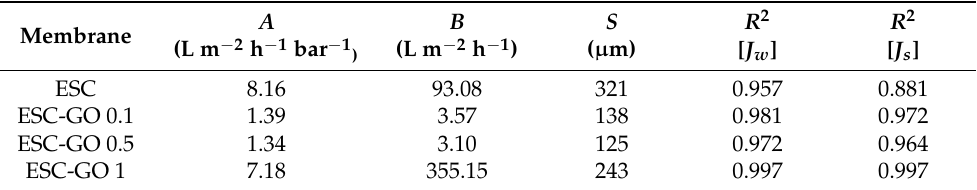
Table 1. Parametric performances of biocomposite membranes. Membrane